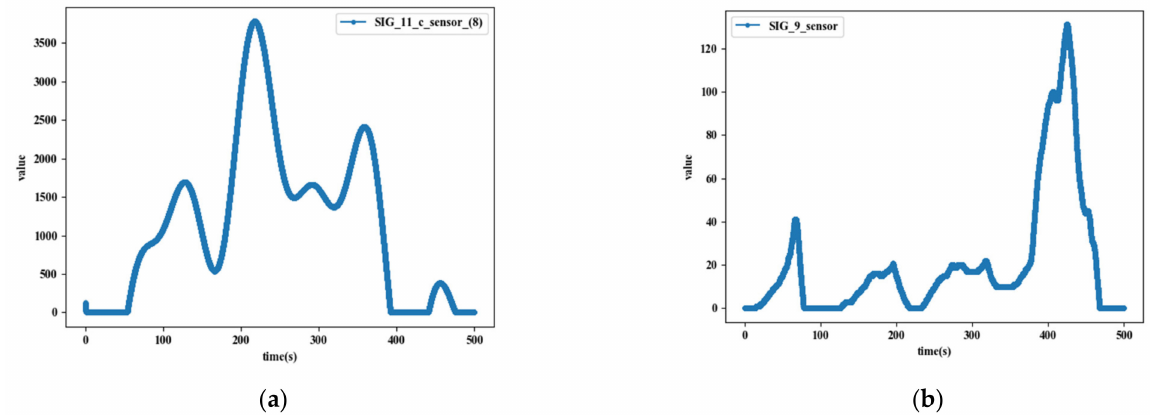
Figure 4. Examples of synthetic SENSOR Type-1 ( a ) and Type-2 ( b ).